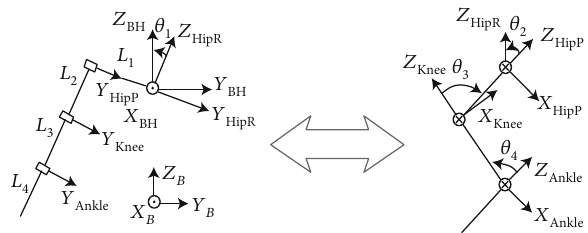
Figure 3: One leg kinematic model of the quadruped